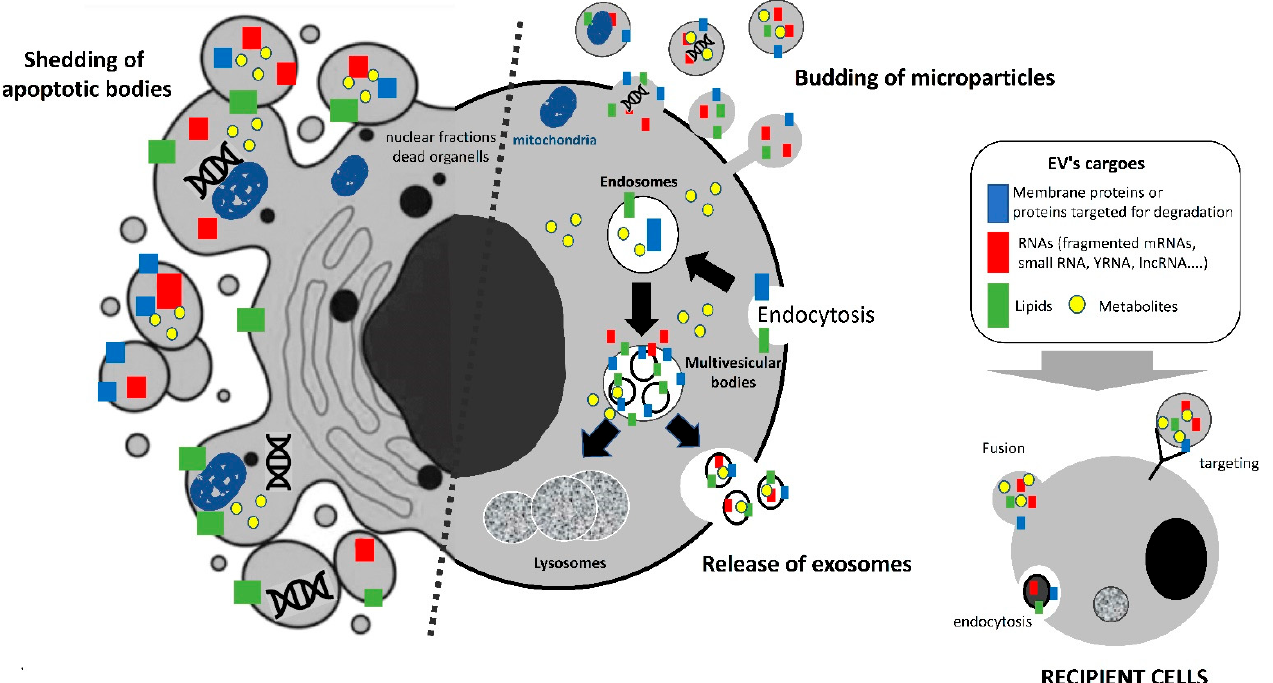
Figure 1. Different populations of extracellular vesicles released from almost all cell types. The relative proportion of microvesicles and exosomes is variable and depends on each cell type. Apoptotic bodies contain information from dying cells, such as DNA, fragmented RNA, and organelle material. Mitochondrial DNA has been described in muscle- and adipocyte-derived EVs. Exosomes and microparticles are released by live cells and can target recipient cells either via receptor interactions, direct fusion, or endocytosis/pinocytosis.